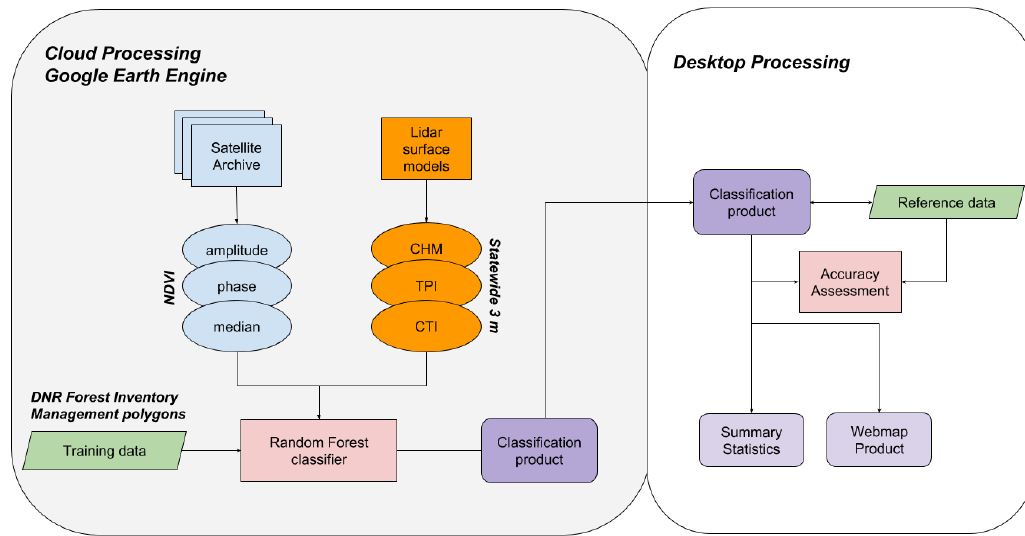
Figure 2. Concept flowchart of model development for ash classification. The Google Earth Engine platform was used for processing Landsat surface reflectance imagery and producing the classification product. Server-side computing enabled use of the Landsat Archive and allowed easy modification to the analysis. Validation was performed outside of the cloud environment to ensure data security and to allow integration with additional GIS layers.